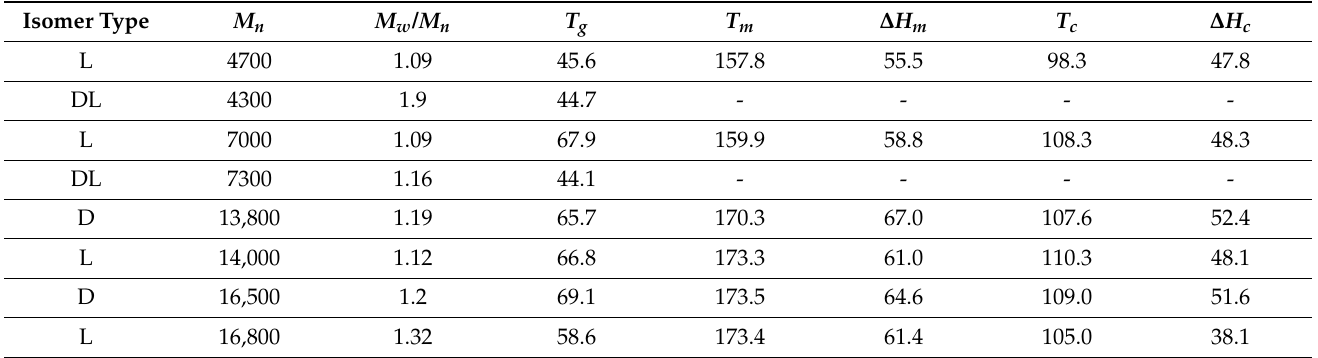
Figure 2. Examples of molecular configurations of PLA obtained through combining the two lactic acids. Table 9. Properties of PLA with different isomer types and varying molecular weights [59] .